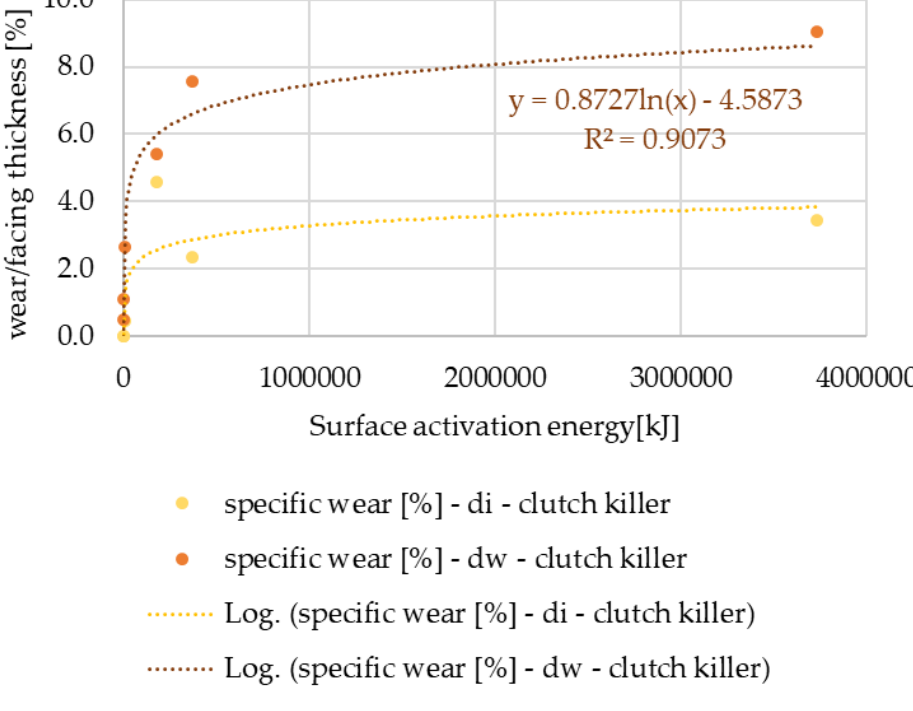
Figure 7. Wear % values versus facing thickness as a function of surface activation energy — clutch killer facings.